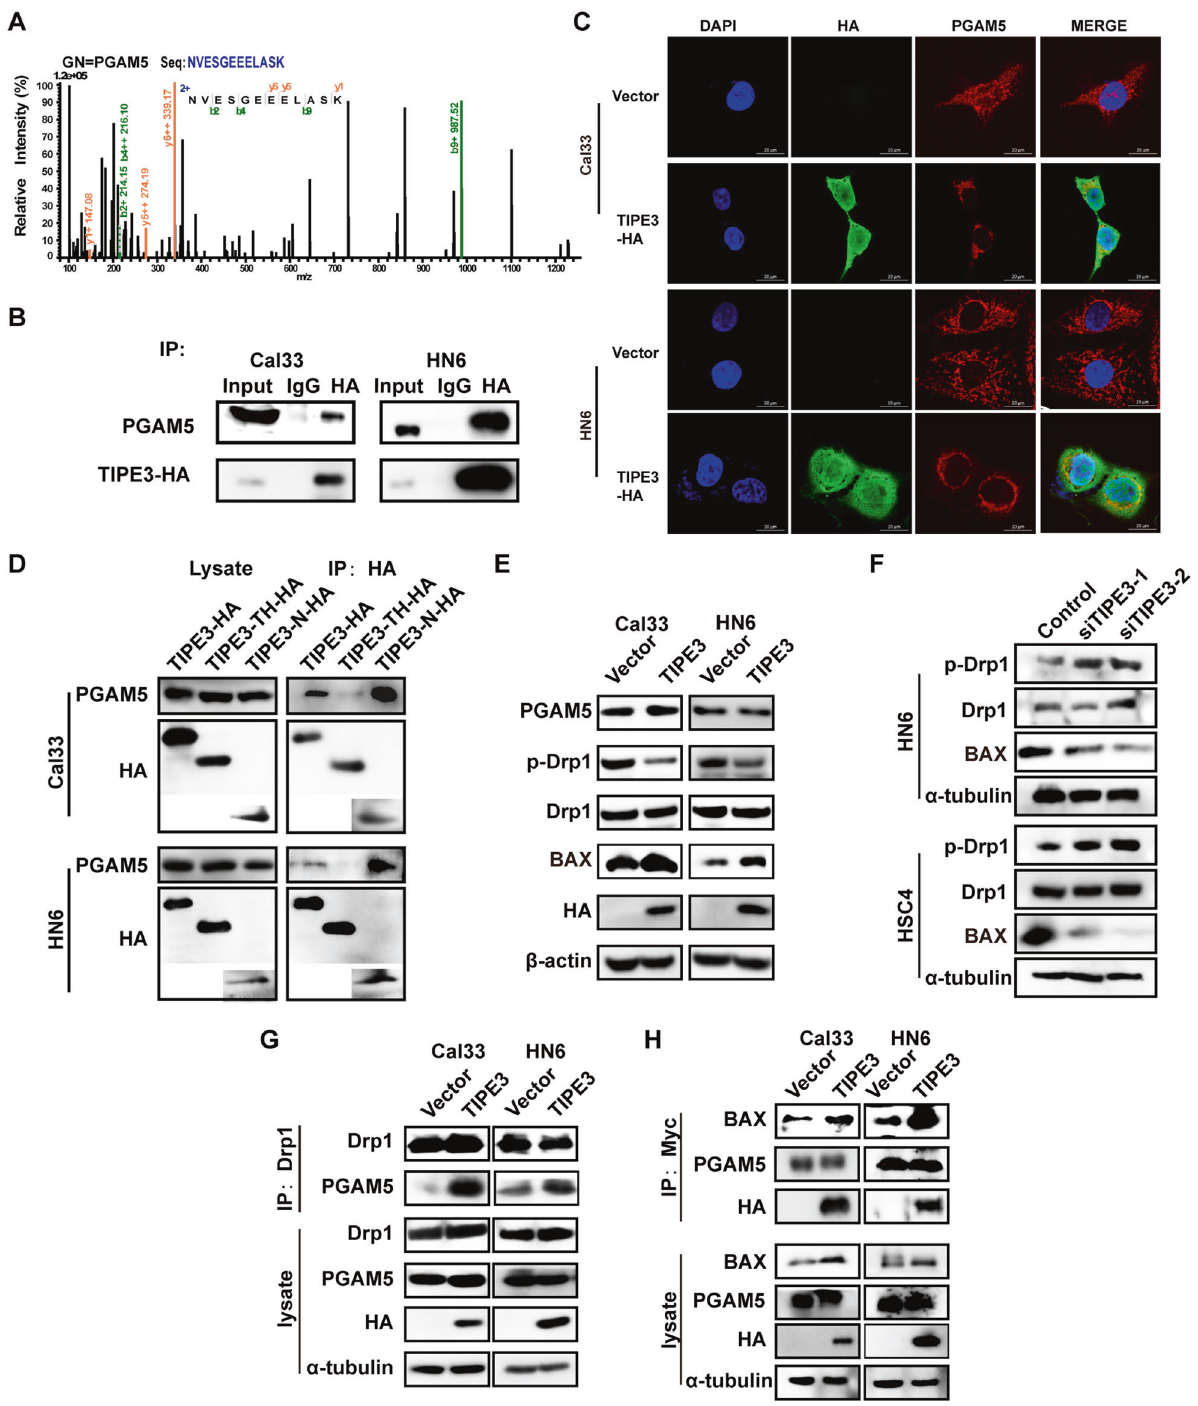
Fig. 5 TIPE3 induces mitochondria stress via promoting PGAM5 dephosphorylating p-DRP1. A MS of PGAM5 proteins identi fi ed by Co-IP. B Physical interactions between TIPE3-HA and PGAM5 were examined via Co-IP/WB in Cal33 and HN6 cells with TIPE3-HA overexpression. C Immuno fl uorescence imaging of co-localization of TIPE3-HA and PGAM5. D Physical interactions between full-length TIPE3-HA, truncated TIPE3 (trTIPE3), NT region (NT), and PGAM5 were examined via Co-IP/WB in Cal33 and HN6 cells with TIPE3-HA overexpression. E , F Expressions of PGAM5, p-DRP1 ser637 , DRP1, BAX, HA, β -actin, and α -tubulin were determined by WB. G , H Physical interactions between DRP1 and PGAM5 ( G ), PGAM5 and BAX ( H ) were examined via Co-IP/WB in Cal33 and HN6 cells with vector or TIPE3-HA overexpression. progression in vitro and in vivo [17]. However, the mechanism of cancers, including bladder cancer, colon and rectal cancer, lung its tumor suppression effect is unknown. In the present study, we cancer, prostate cancer, and HNSC in TCGA. For the fi rst time, we comprehensively analyzed the expression alterations of TIPEs and found that overexpressing full-length TIPE3 acted as a tumor their correlations with HNSCC clinical outcomes using public suppressor and suppressed nasopharyngeal carcinoma (NPC) cells